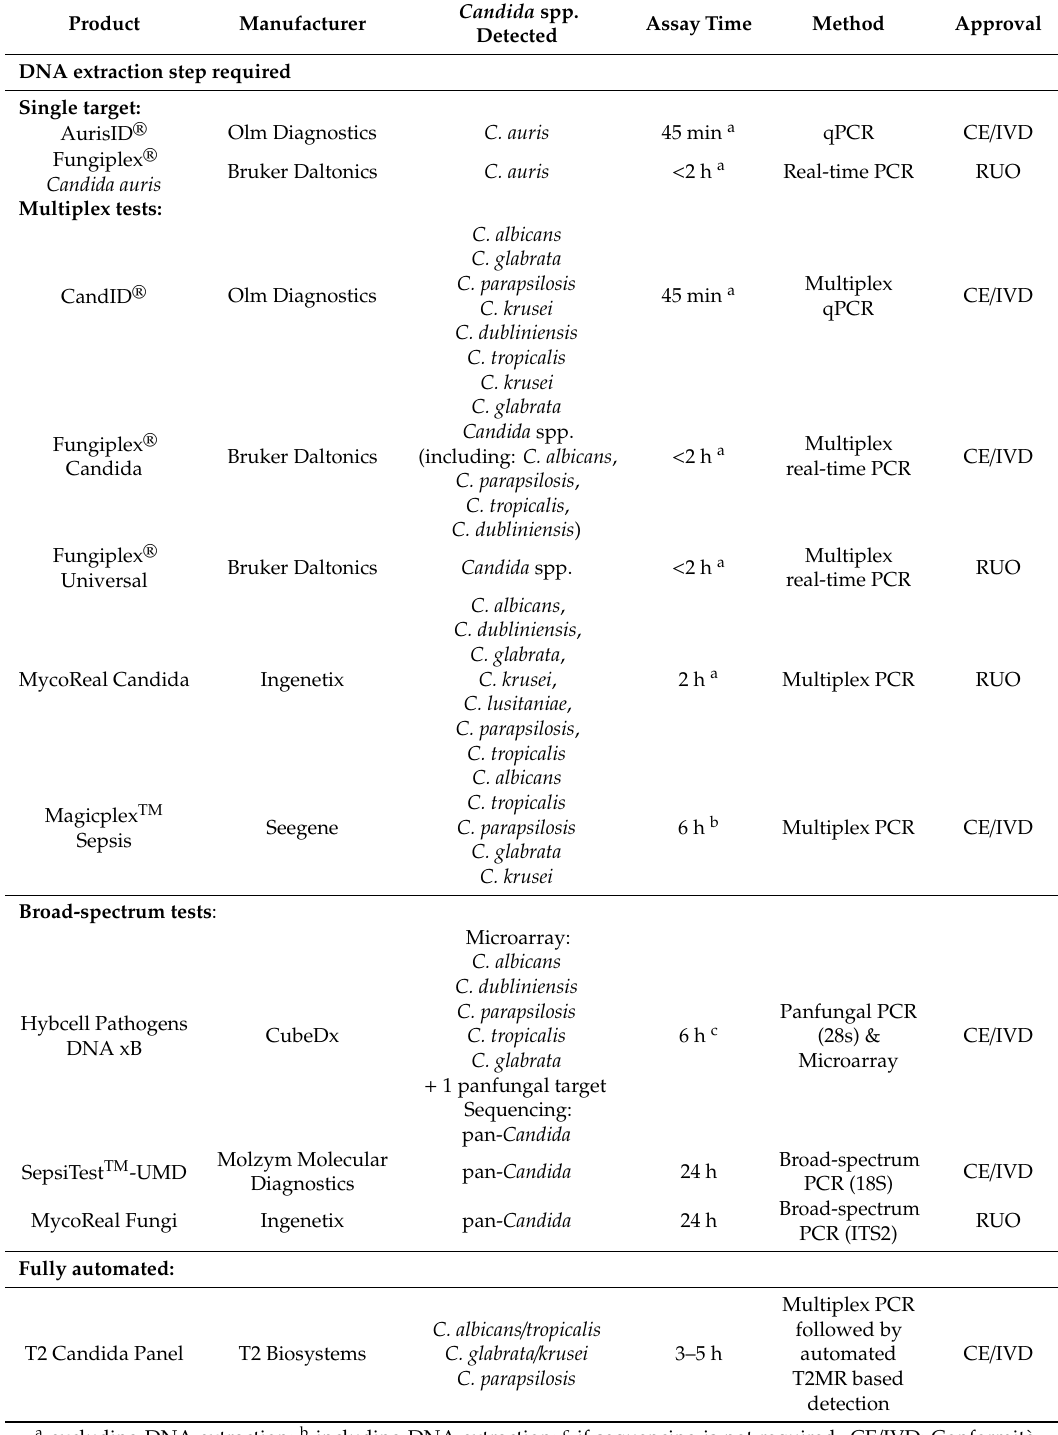
Table 2. List of blood culture independent